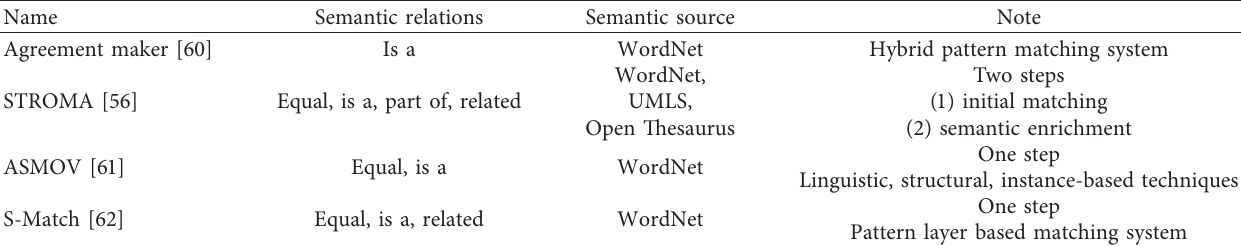
Table 15: Existing semantic